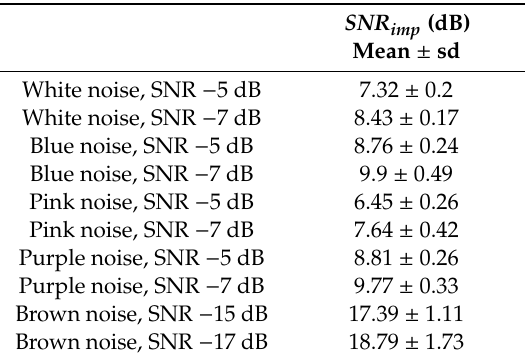
Table 2. SNR imp expressed as mean ± sd.